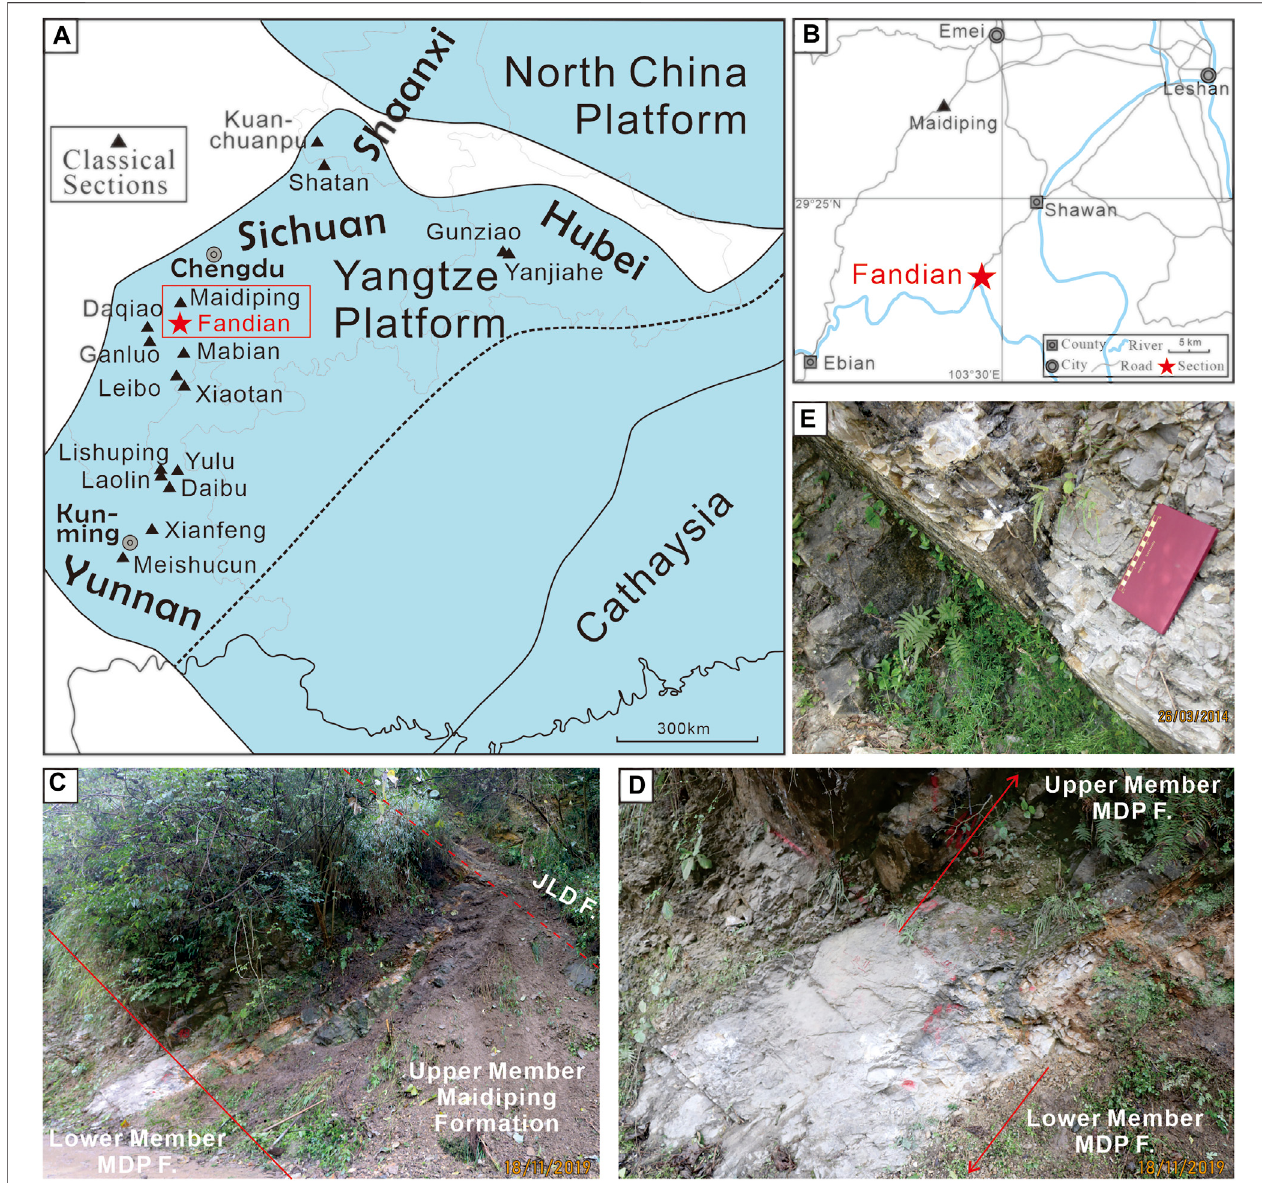
FIGURE 1 | Location map and fi eld photographs of the Fandian section. (A) General location of the Fandian section and other classical sections with diverse small shellyfossilsonthewesternYangtzePlatform(modi fi edfromSteineretal.,2007). (B) Traf fi cmapshowingthedetailedlocationoftheFandiansection. (C) Overviewofthe upper part ofthe Fandian section. (D) Boundaryofthe lower and upper members ofthe MaidipingFormation (MDP F.). (E) Gray dolostone with a few thin chert layers of the Lower Member of the Maidiping Formation. Abbreviation: JLD F., Jiulaodong Formation.